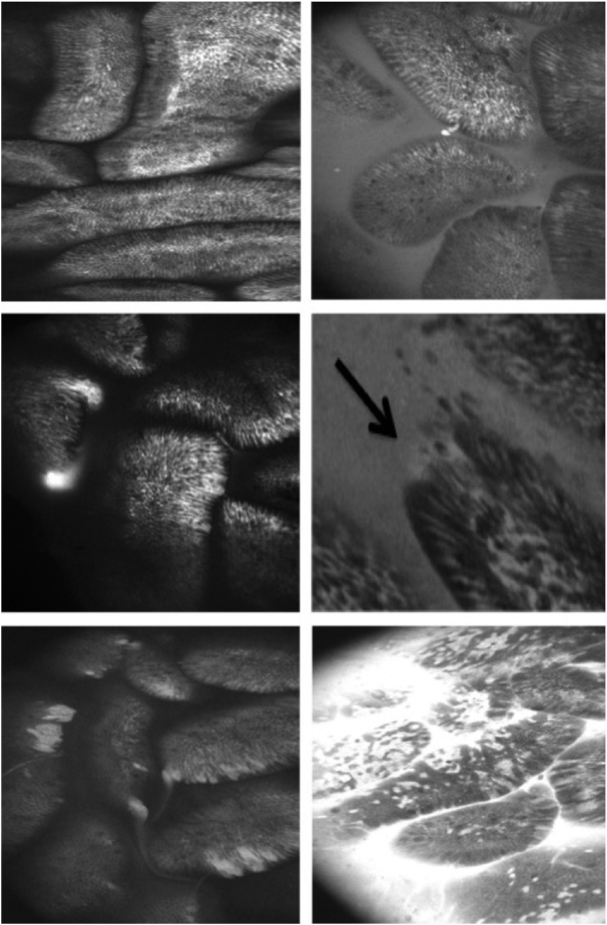
Examples of reproducible endomicroscopic signs of barrier dysfunction. Top left: intact mucosa; no leak; intervillous space is black (normal; Watson grade I). Top right: background luminal fluorescein (functional defect; Watson grade II) with a single apoptotic cell shedding event (nonpathological). Centre left: fluorescein plume with no mucosal defects (functional defect; Watson grade II). Center right: apical microerosion (multiple cell defect) with background fluorescein leakage (structural defect; Watson grade III). Bottom left: multiple microerosions with multiple fluorescein plumes (structural defect; Watson grade III). Bottom right: florid fluorescein leak within and out of the mucosa with multiple microerosions (structural defect; Watson grade III).